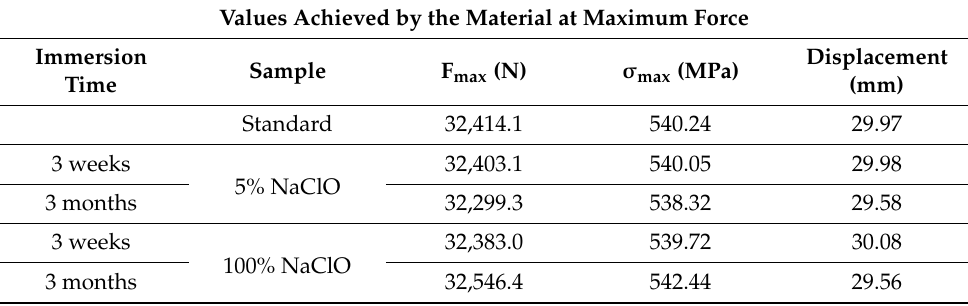
Table 3. Values reached by Duplex 14462 after three weeks and three months at maximum